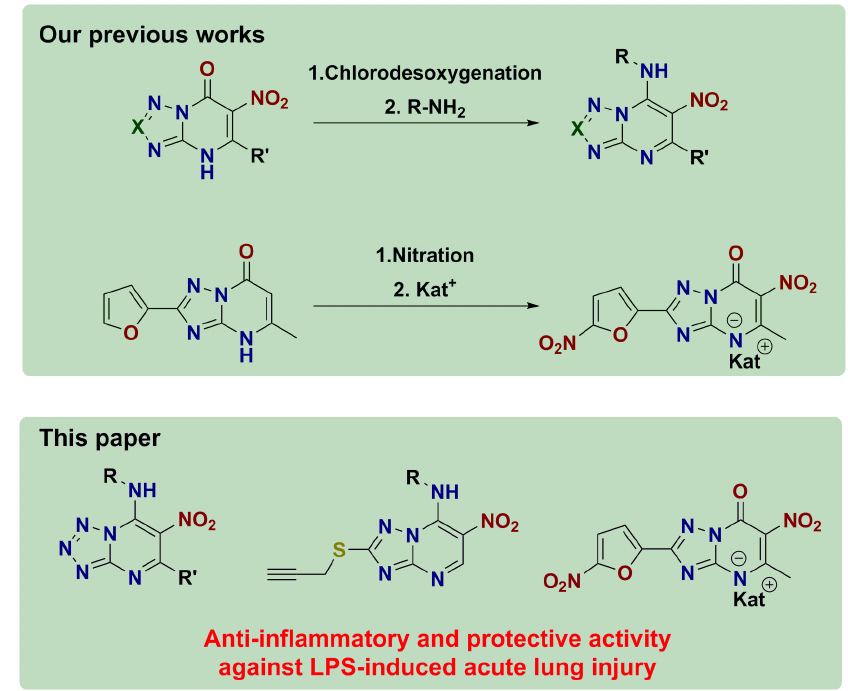
Figure 2. Background of this work [24 ‒ 26].